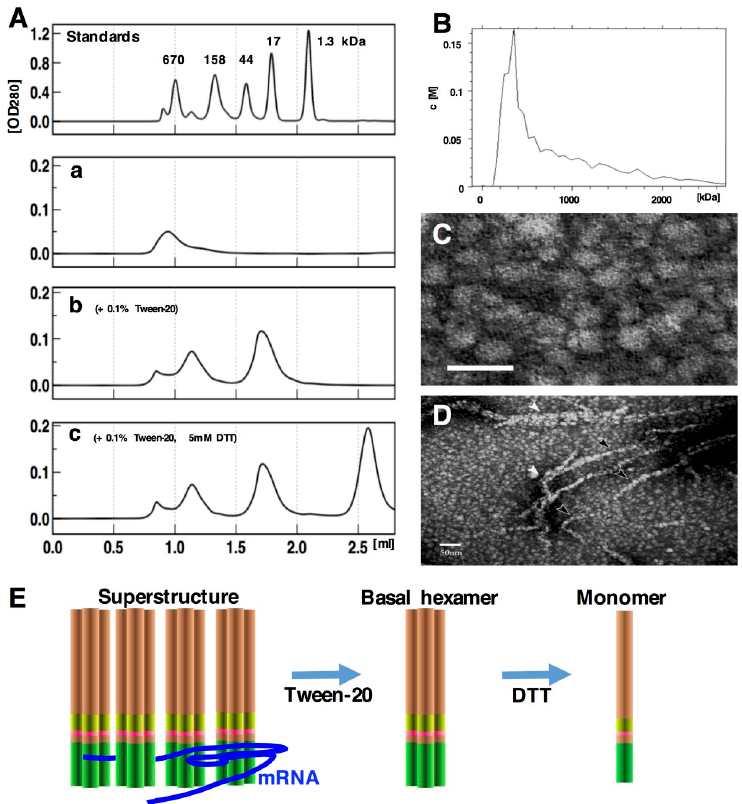
Fig 1. Multimer formation by RodZ. (A) Gel filtration of purified RodZ wt: in RNA binding buffer [19]. Standards: Elution profile of molecular standards in the same condition: 670 kDa, thyroglobulin; 158 kDa, bovine γ -globulin; 44 kDa, ovalbumin; 17 kDa, myoglobin; 1.35 kDa, cyanocobalamin. a: Elution profile of RodZ wt (0.5 mg/ml, 40 μ l). b: Elution profile in RNA binding buffer containing 0.1% Tween-20. c: Elution profile in RNA binding buffer containing 0.1% Tween-20 and 5 mM dithiothreitol. (B) Analytical ultracentrifugation of RodZ wt (1 mg/ml). (C) TEM image of purified RodZ wt . Scale bar = 25 nm. (D) Low magnification of the same sample. (E) Illustration for the three forms of RodZ complexes.